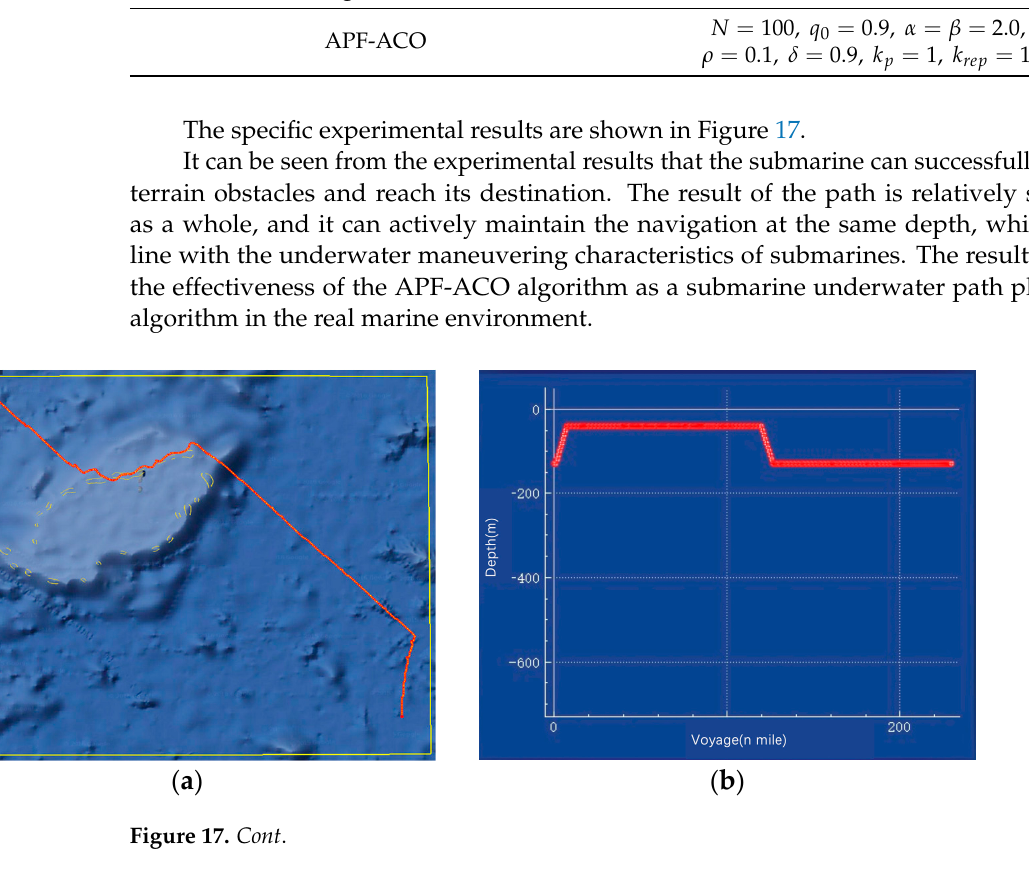
Table 7. Parameter Settings of the System test.